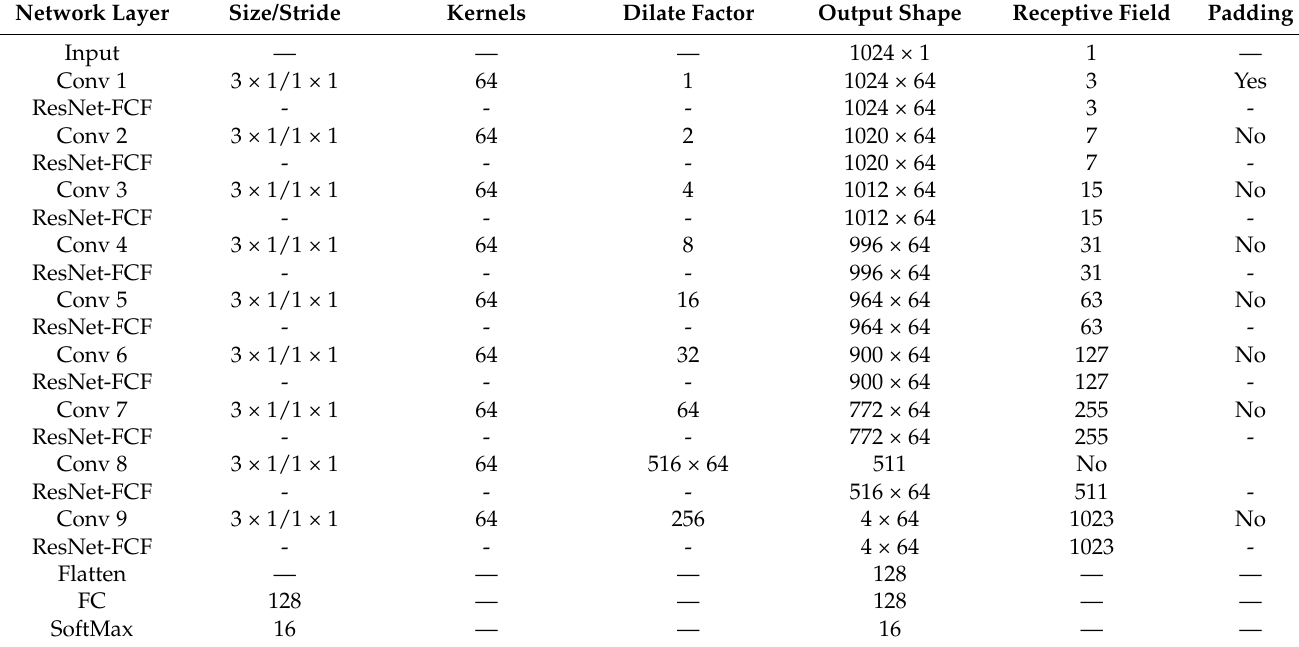
Table 2. Parameters of the ECNN